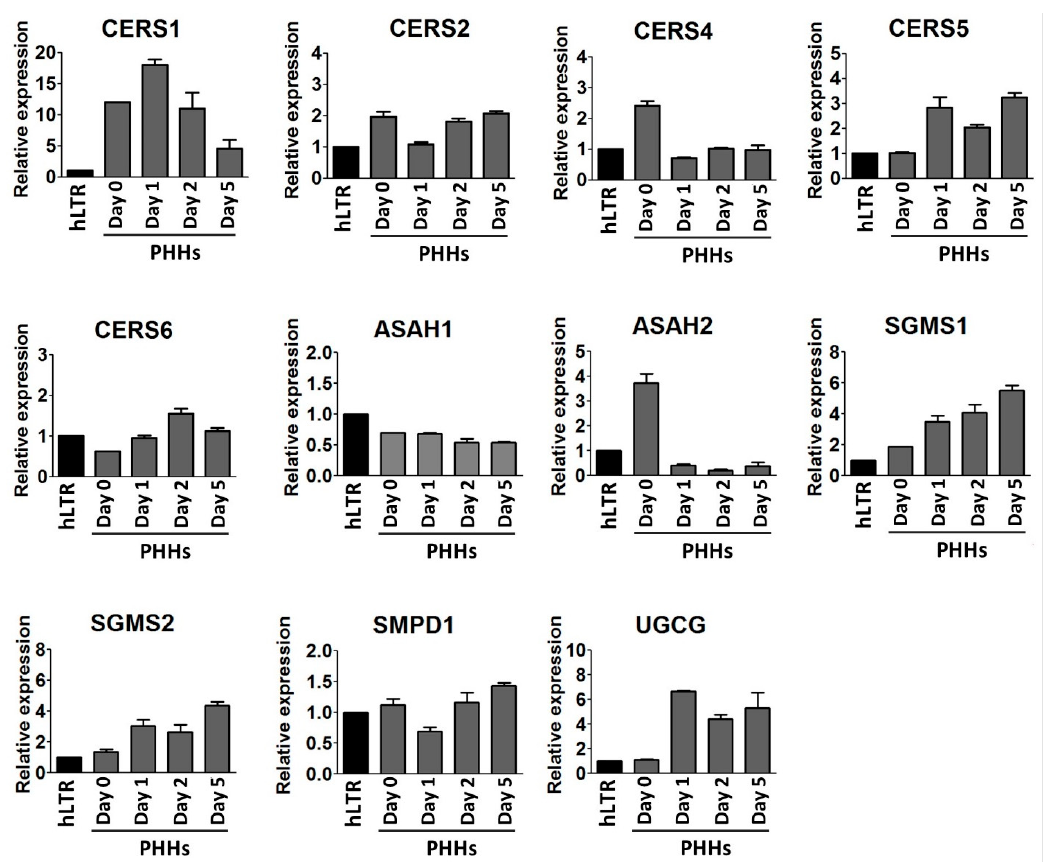
Figure 3. qPCR analysis of key genes involved in the metabolism of sphingolipids (SLs) studied in PHHs during their five days in the culture. The expression of CERS1 , CERS2 , CERS4 , CERS5 , CERS6 , ASAH1 , ASAH2 , SGMS1 , SGMS2 , SMPD1 , and UGCG genes in PHHs at time points day 0, 1, 2, and 5. The expression of each gene was normalized to both GAPDH and B2M as endogenous controls. The values are presented relative to the hLTR sample. Each sample was run in technical triplicate and bars represent mean ± SD of three biological replicates.